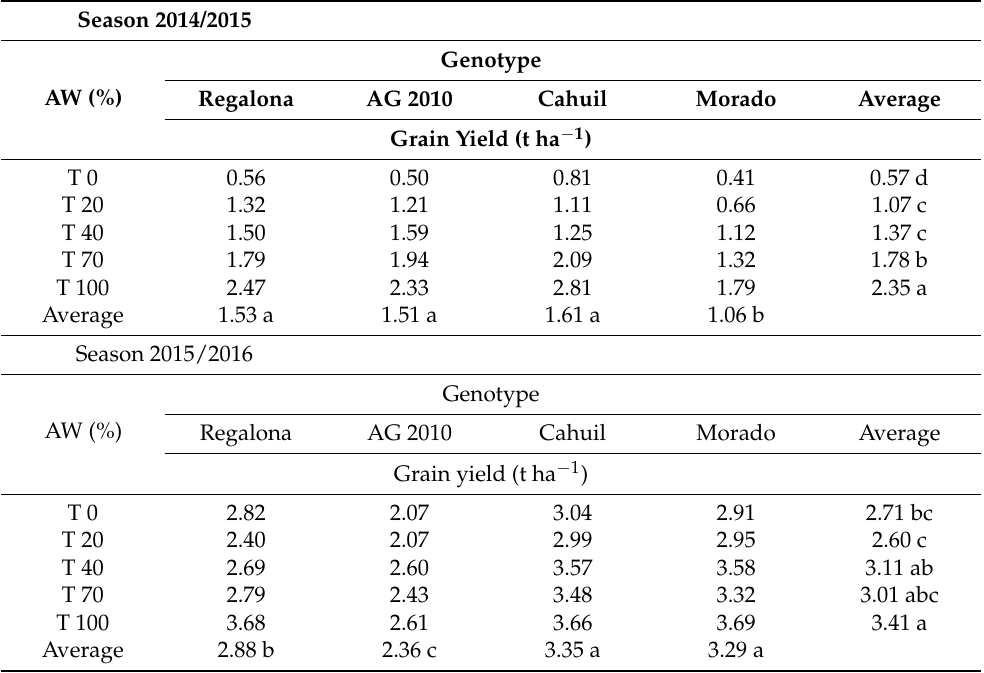
Table 1. Grain yield for five water availability treatments (T) and four quinoa genotypes in